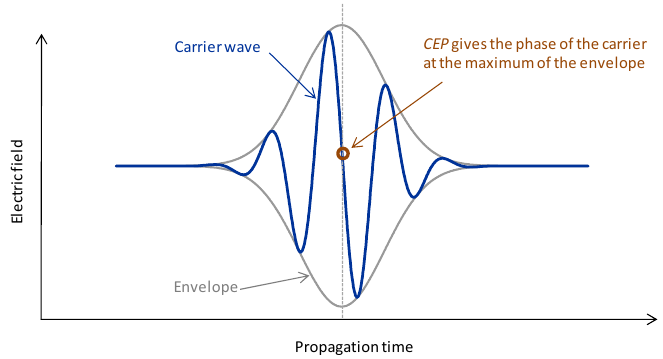
Figure 2. Definition of the carrier-envelope phase.